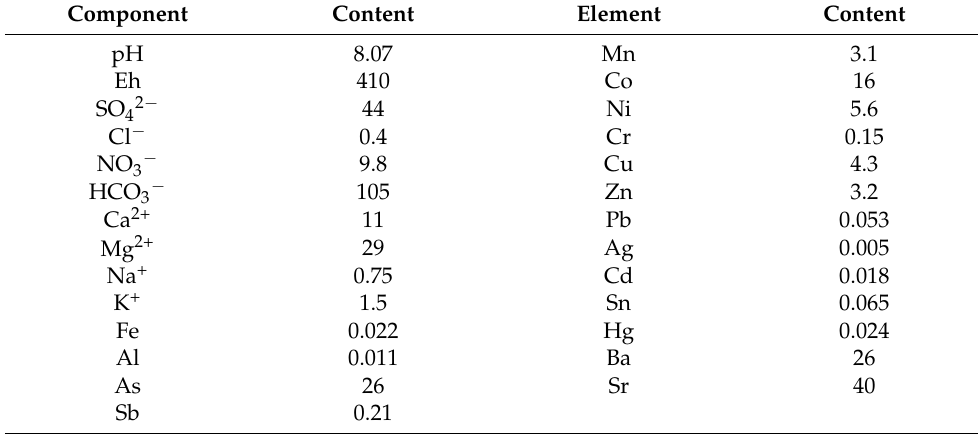
Table 3. Composition of water extract (sample KhA tot WE): Eh in mV, SO 42 − –Sb in mg/L, and Mn–Sr in µ